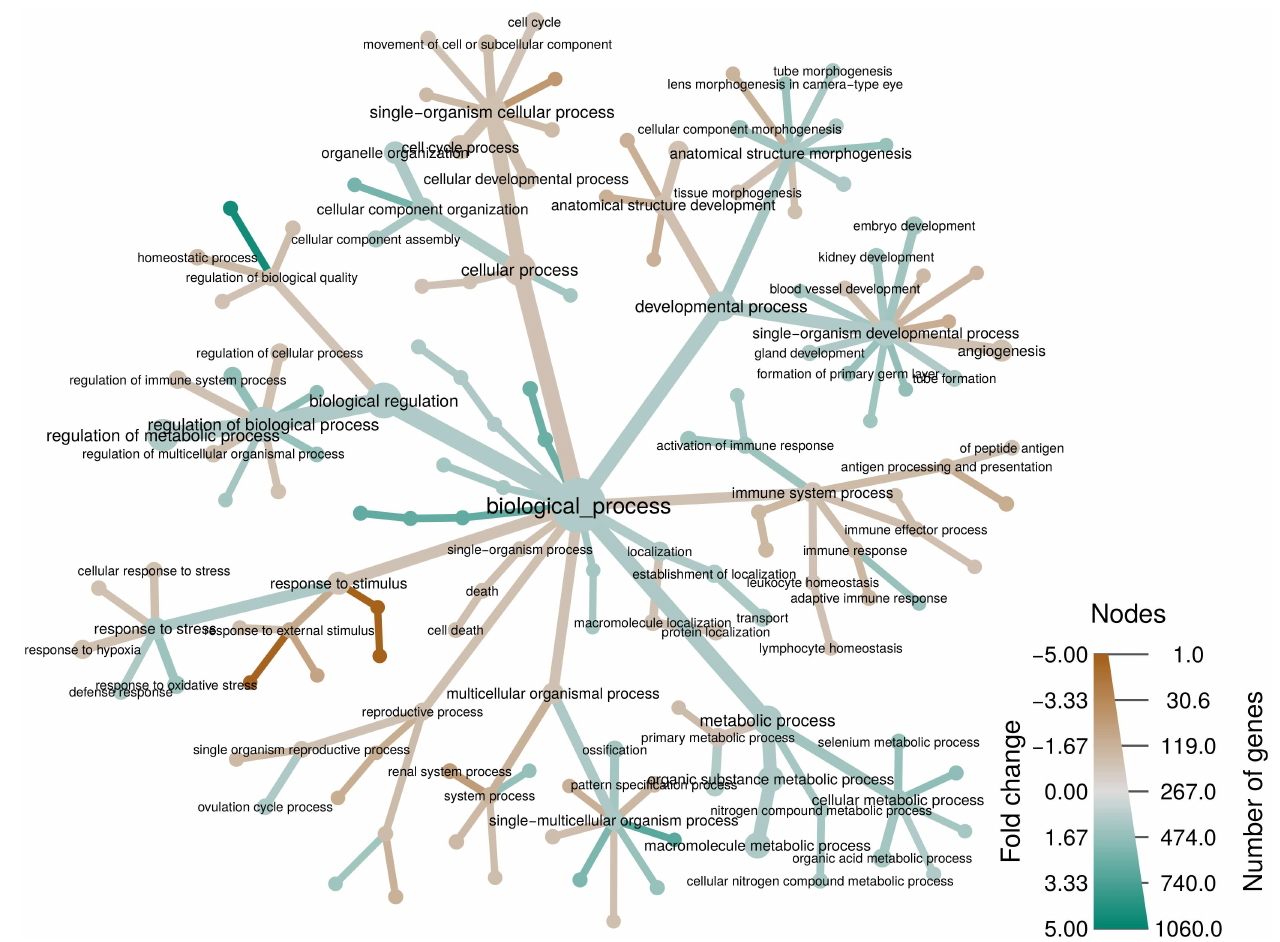
Fig 7. Another alternate use example: Visualizing gene expressiondata in a GO hierarchy. The gene ontologyfor all differentially expressedgenes in a study on the effect of a glucocorticoid on airway smooth muscle tissue [19]. Color indicatesthe sign and intensity of averagedchangesin gene expressionand the size indicatesthe numberof genes classifiedby a given gene ontology